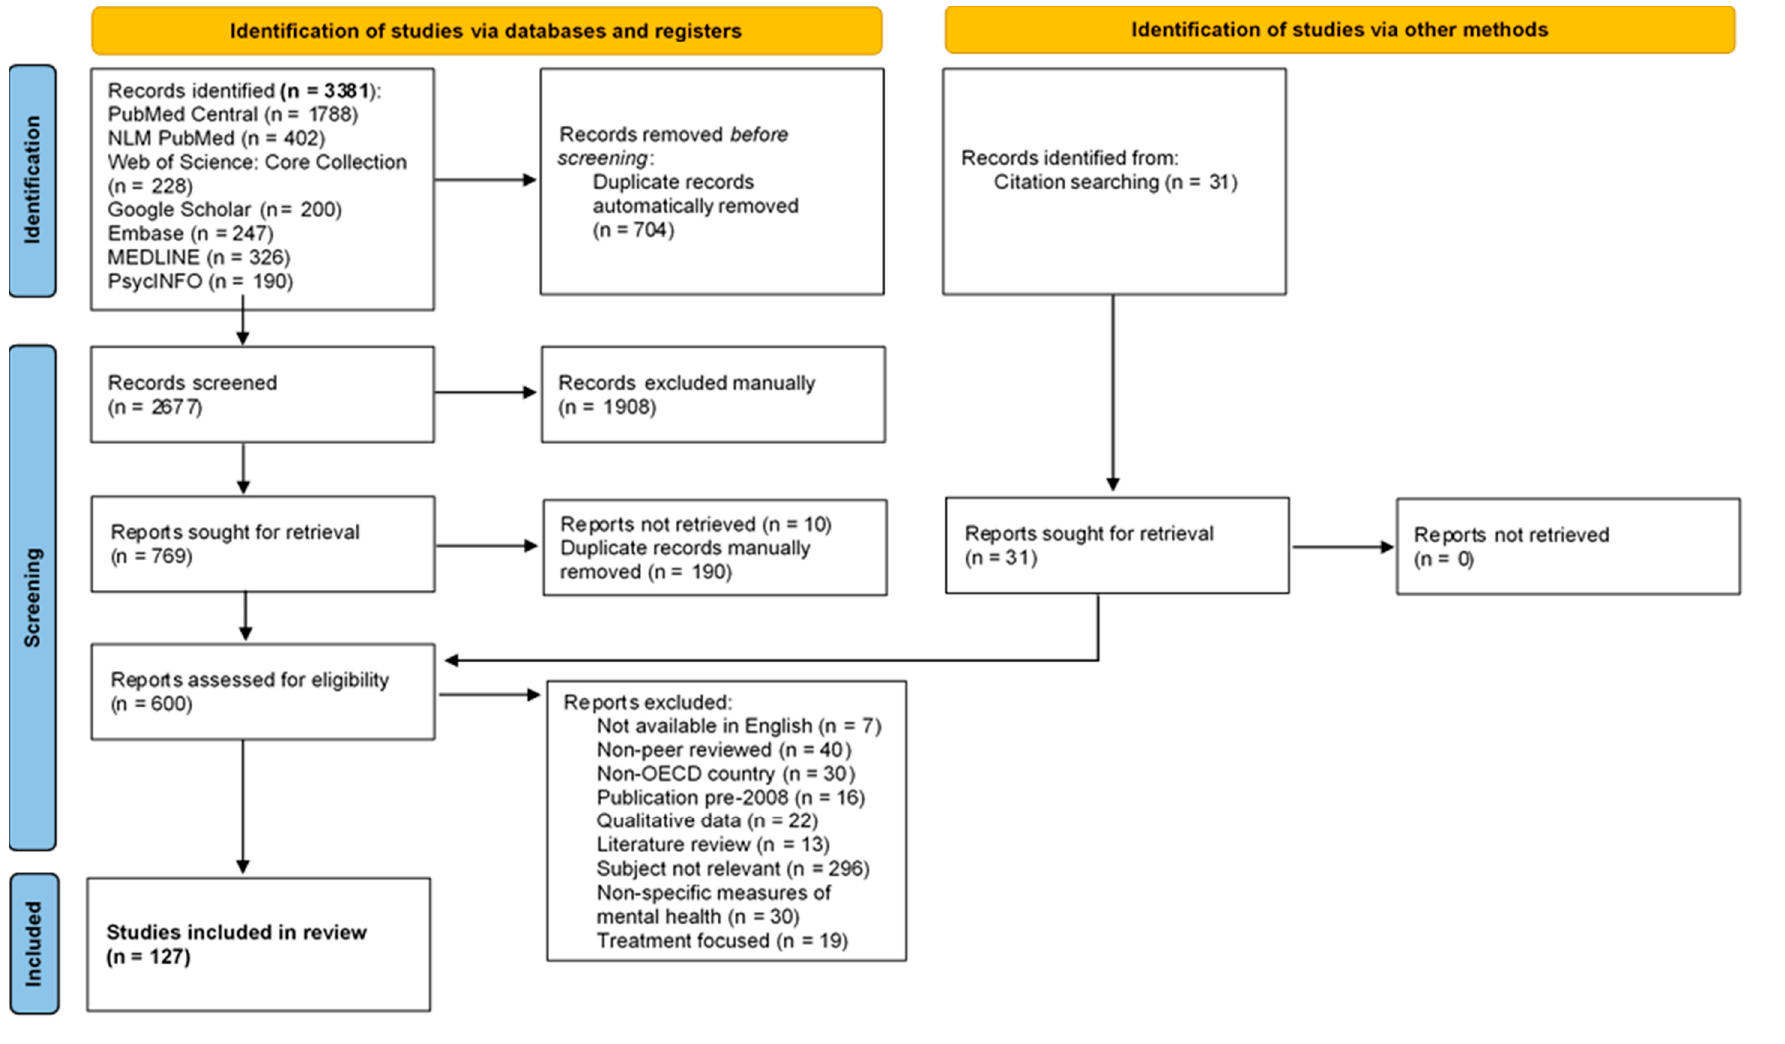
Figure 1. PRISMA literature search summary [9] .